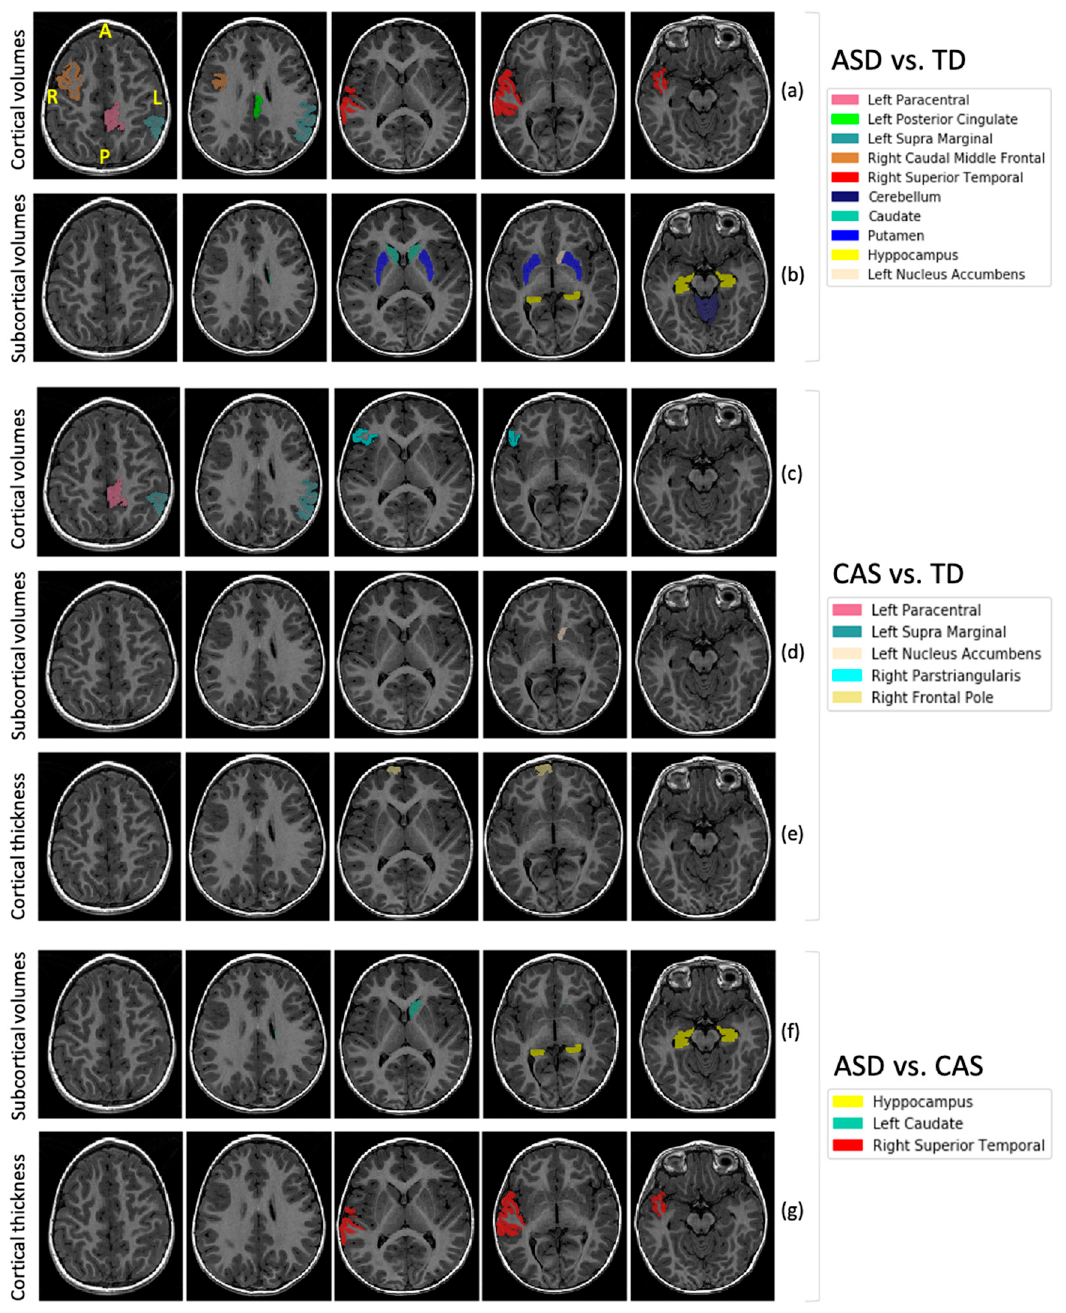
Figure 2. Visualization of brain regions whose features showed statistically significant differences among the three groups of subjects (see Table 2 for the complete list of features, including also global volumes). The overlay of FreeSurfer segmented regions onto the anatomical image of a representative subject is shown for specific alterations in the ASD vs. TD ( a , b ), CAS vs. TD ( c – e ) and ASD vs. CAS ( f , g ) comparisons. The involved set of features, i.e., the cortical and subcortical volumes, and the cortical thicknesses, are indicated in each figure